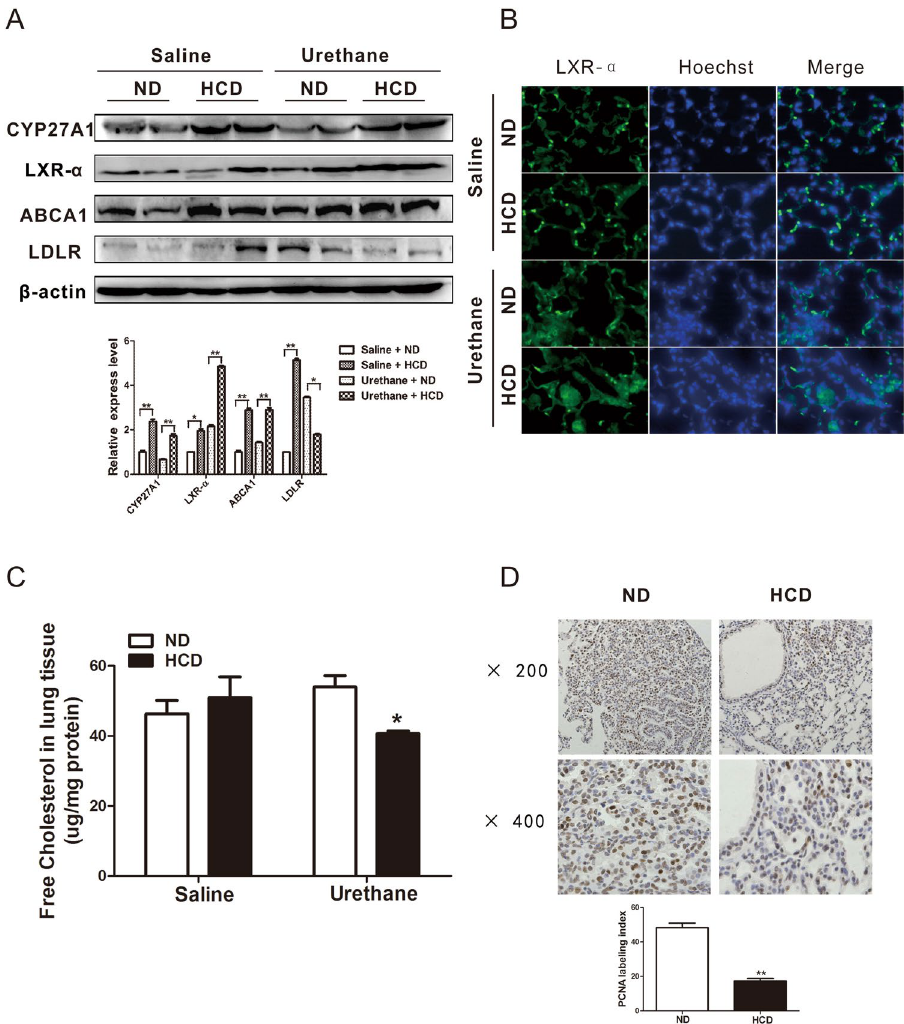
Figure 4. Elevated LXR activation in urethane treated HCD-fed C57BL/6J mice compared to ND-fed mice. ( A ) Western blotting for the expression of CYP27A1, LXR- α , ABCA1 and LDLR in the lung tissues collected at experimental week 13. Representative two mice results in each group and cropped gels/blots were displayed in the photos. Densitometry quantification was analyzed among 3 to 5 mice per group using Image J software. β -actin was used as the internal cytoplasma protein control. ( B ) Localization of LXR- α in the lung tissues through immunofluorescence techniques. green: LXR- α , blue: nucleus. original magnification: × 400. ( C ) Concentration of free cholesterol in lung tissues collected at experimental week 13 were measured with enzymatic assay (n = 3–5 per group). ( D ) Immunohistochemistry study of lung proliferation status using anti-PCNA antibody at experimental week 28. Dark brown color indicates the PCNA positive cells (original magnification: × 200; × 400). The PCNA labeling index was the percentage of PCNA-positive cells among total counted cells. n = 5 mice per group. Columns, mean; bar, SEM. * P < 0.05; ** P <